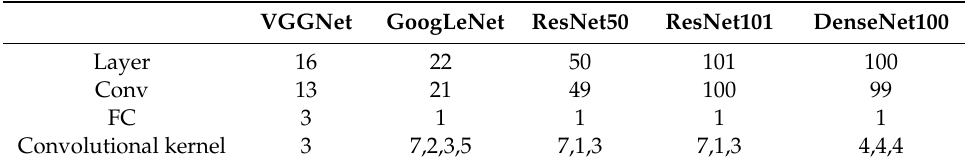
Table 3. The architecture of the baseline model.